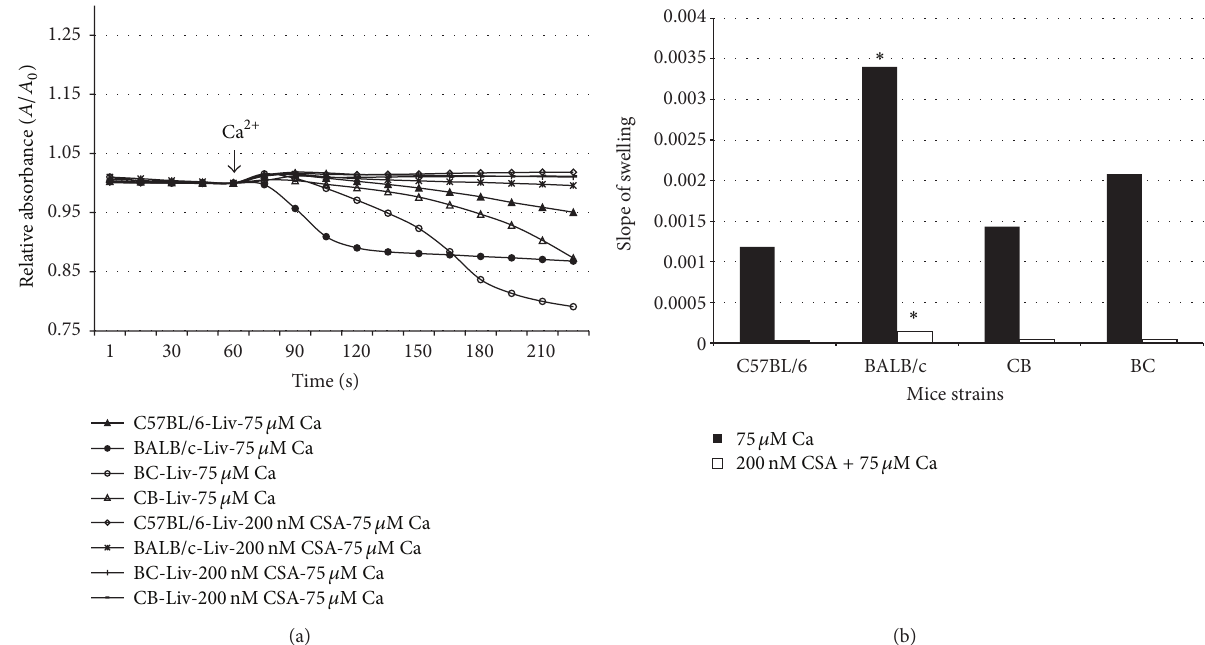
Figure 4: Calcium-induced hepatic mitochondrial swelling in 4 mouse strains. Hepatic mitochondria from C57BL/6, BALB/c, and C57BL/6 × BALB/c F1 hybrid mice were isolated. Calcium concentrations of 75 𝜇 M with or without 200 nM CSA were used to induce mitochondrial permeability pore opening. The response of mitochondria to calcium overload was recorded in 10-second intervals with a 540 nM spectrometer. Parental background significantly influenced the response of offspring to calcium overload. CSA was found to have a significant inhibitory effect in C57BL/6 mice and the F1